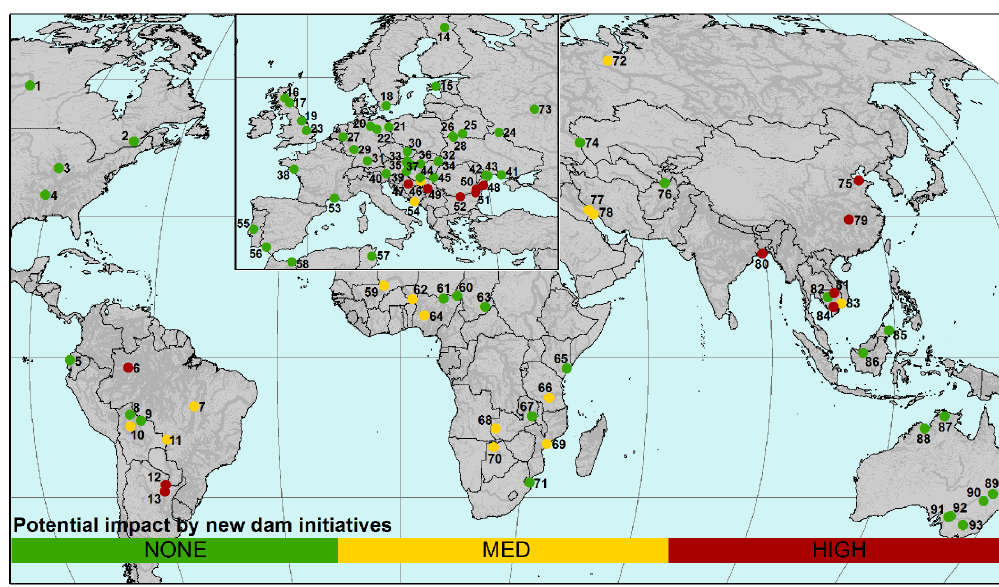
Figure 4. Potential impact of new dam initiatives taking into account dams currently planned or under construction in the upstream area of each riparian